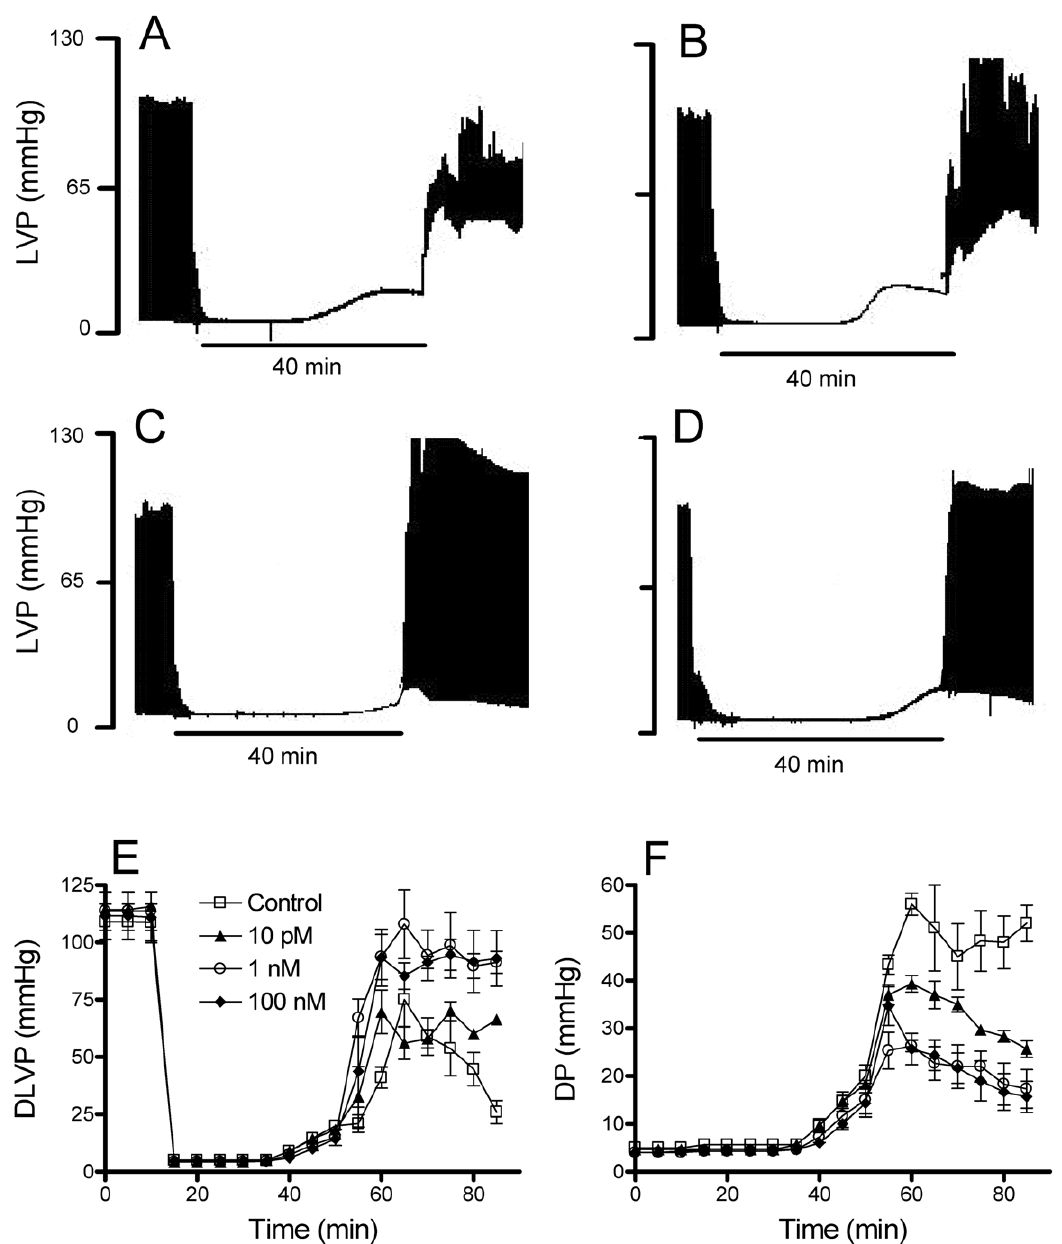
Figure 1. PD153035 improves cardiac function after ischemia/reperfusion. Panels A–D : Perfused rat hearts were submitted to left ventricular pressure measurements after 15 min stabilizing perfusion, as described in the Methods section. PD153035 was present at 10 pM, 1 nM or 100 nM ( Panels B , C and D , respectively) during the full experimental period. Panel A shows hearts in the absence of PD153035. After 10 min, the hearts were submitted to 40 min ischemia by interruption of coronary flow, followed by 35 min reperfusion. Data are representative traces of 3 similar repetitions. LVP: Left ventricular pressure. Panels E–F : Averages 6 SEM of 3 experiments conducted under the conditions of Panels A–D. DLVP: developed left ventricular pressure; DP: diastolic pressure. Values for 10 pM, 1 nM and 100 nM PD153035 concentrations were significantly different from controls at 85 min ( p , 0.05).